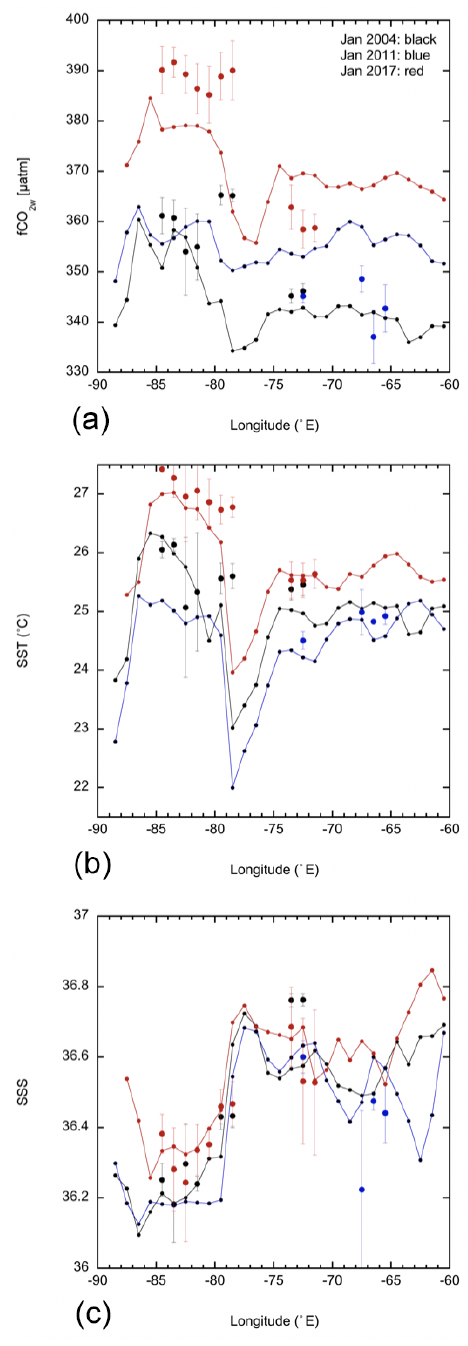
Figure 4. Zonal section of gridded and mapped products between 23 and 24 ◦ N for January 2004 (black), January 2011 (blue) and Jan- uary 2017 (red). (a) f CO 2w ; (b) SST; (c) SSS. The lines with small solid circles are the mapped product; the larger solid circles are the gridded data, with standard deviation of data in the box shown as error